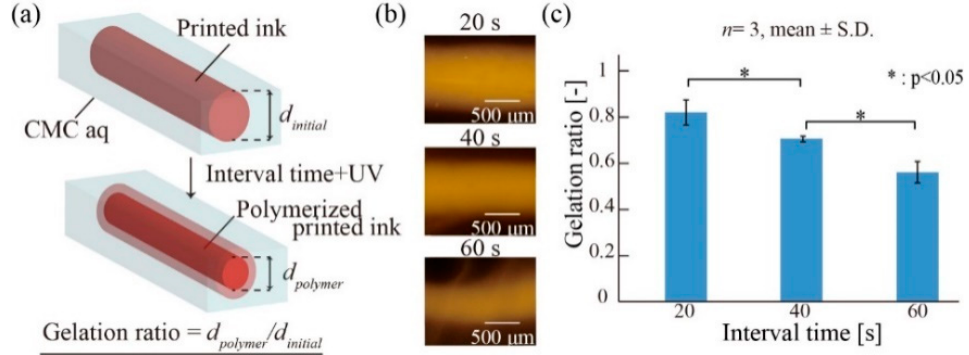
Figure 6. Polymerization of the printed ink in CMC aq. ( a ) Gelation ratio is defined as the diameter of the polymerized ink after UV irradiation divided by the diameter of the printed ink pattern before UV irradiation. ( b ) Fluorescence images of the polymerized printed ink. ( c ) Gelation ratio for different interval times. The gelation ratio decreased as interval time increased.